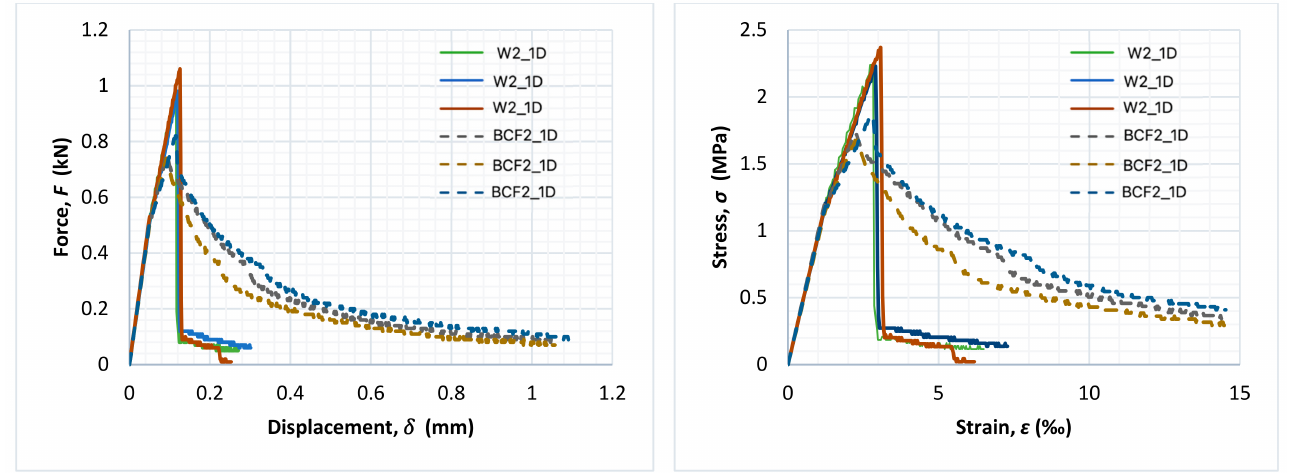
Figure 8. Force–displacement and stress–strain curves for the entire test duration for each specimen of series W2_1D (continuous line) and BCF2_1D (dashed line).